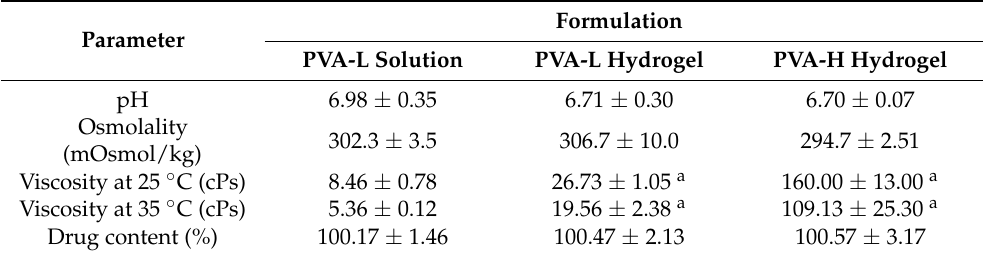
Table 6. The pH value, osmolality, viscosity and drug content of VCZ eyedrop formulations (mean ± S.D., n = 3).